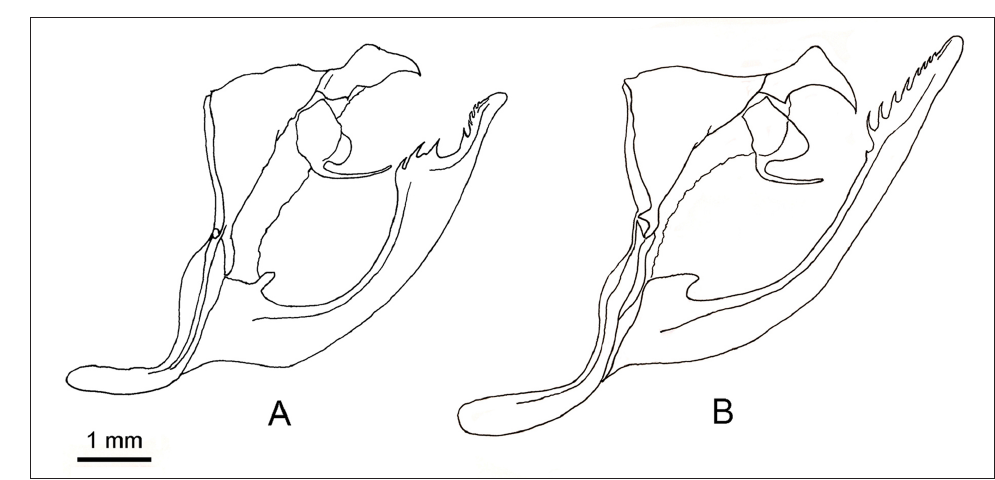
Fig. 10. Male genitalia. A . Eryphanis zolvizora zolvizora (Caranavi, Bolivia; MNHN, PBB 2286). B . Eryphanis zolvizora inca ssp. nov., PT (Llactohuaman, Cusco, Peru; MJP).